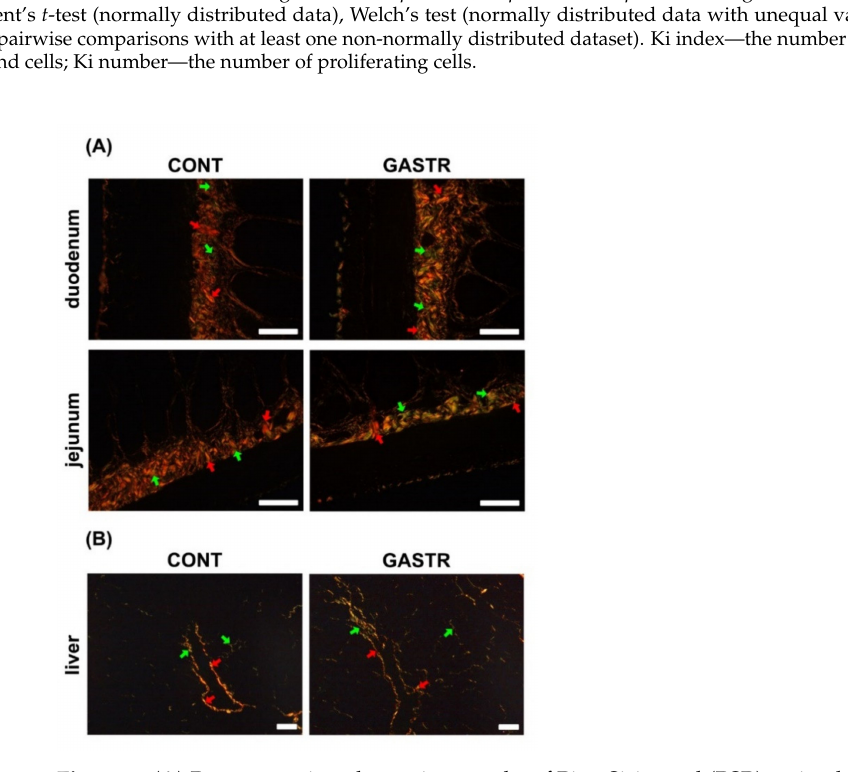
Figure 3. ( A ) Representative photomicrographs of PicroSirius red (PSR)-stained sections of the duo- denum and jejunum. Mature, thick collagen fibers are red-orange, and immature, thin collagen fibers are green. Intestine sections from the CONT group, irrespective of the analyzed fragment, contained thick and thin fibers, with a predominance of thick fibers (red, mature). An increase in immature fibers (thin and green) was observed after gastrectomy. ( B ) Representative photomicrographs of PSR-stained sections of the liver. Liver sections from the CONT group contained thick and thin fibers, with a predominance of thick fibers (red, mature). An increase in immature fibers (thin and green) was observed in the gastrectomy-treated group. Red arrow indicates mature collagen; green arrow indicates immature collagen. All the scale bars represent 50 µ